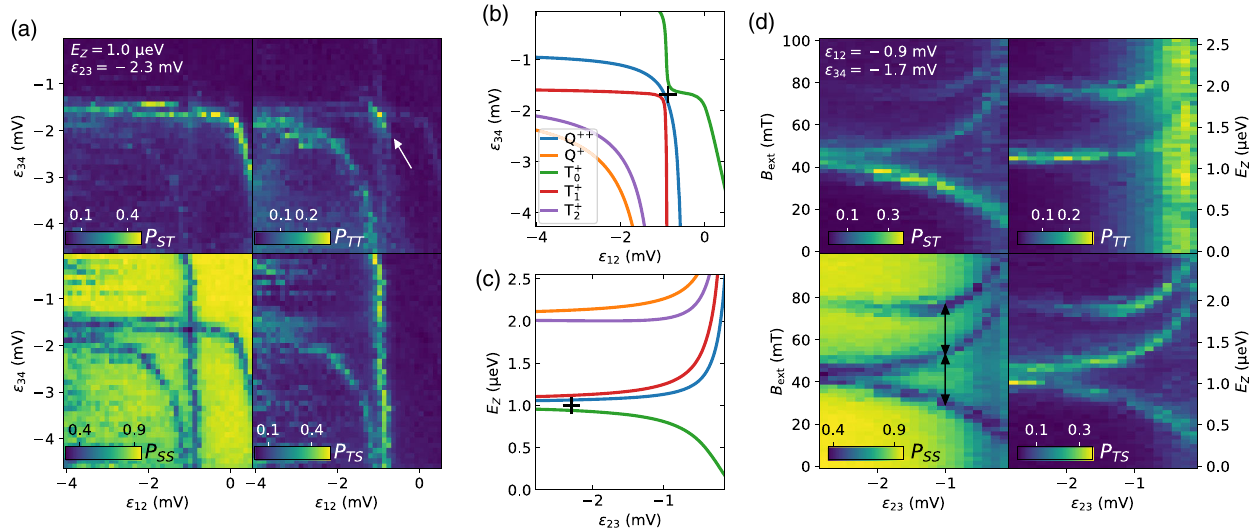
FIG. 2. Energy spectroscopy. Left- and right-pair correlated singlet-triplet probabilities from independent single-shot Pauli spin blockade readout as a function of (a) left- and right-pair detunings and (d) magnetic field and middle-pair detuning. A decrease in singlet-singlet probability and an increase in one of the other probabilities correspond to an anticrossing between the low-energy global singlet state and a polarized state. In (d), the right axis shows the calculated Zeeman splitting taking a Land´e g factor of − 0 . 44 . (b) Numerical simulation of the left- and right-pair detuning for which the low-energy global singlet state is degenerate with a polarized state. The parameters for the numerical simulation are obtained from separate spin funnel measurements for the left and right exchange coupling (see Appendix C 5) and from the Fourier transform in Fig. 3(d). (c) Numerical simulation of the middle-pair detuning and Zeeman splitting for which the low-energy global singlet state is degenerate with a polarized state. The diagram shows only the energies for the polarized states for which the magnetic field lowers the energy. The energy of the low-energy global singlet state is set to zero as a reference. Points in (b) and (c) with the same detunings and magnetic field are indicated with a “ þ ” . The legend for (c) is the same as for